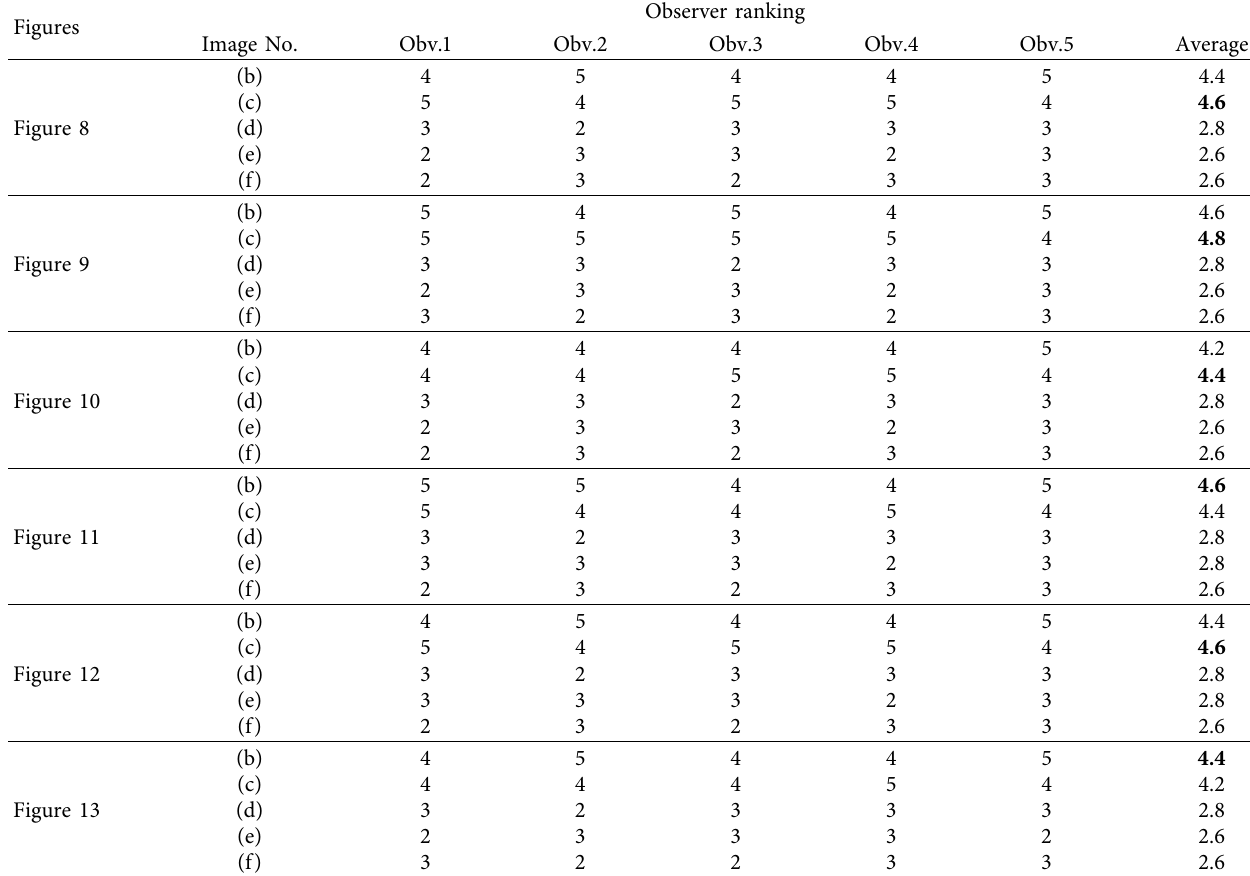
Table 2: Observer’s assessment of experimental results.